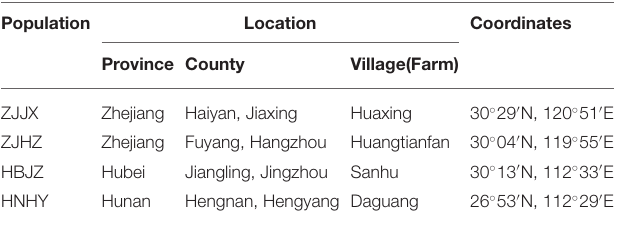
TABLE 1 | Geographic locations of the common roegneria populations used in this study. Population